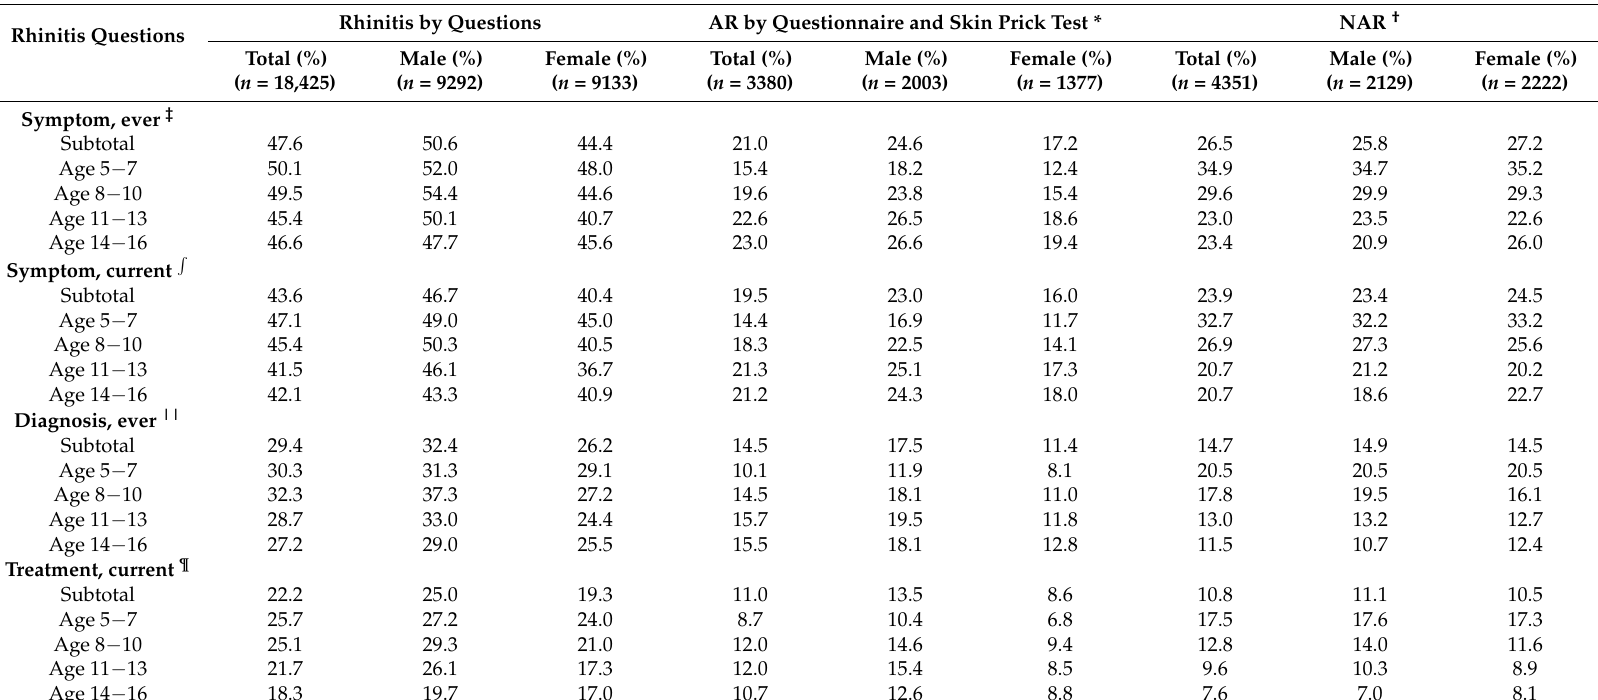
Table 1. Demographic characteristics and